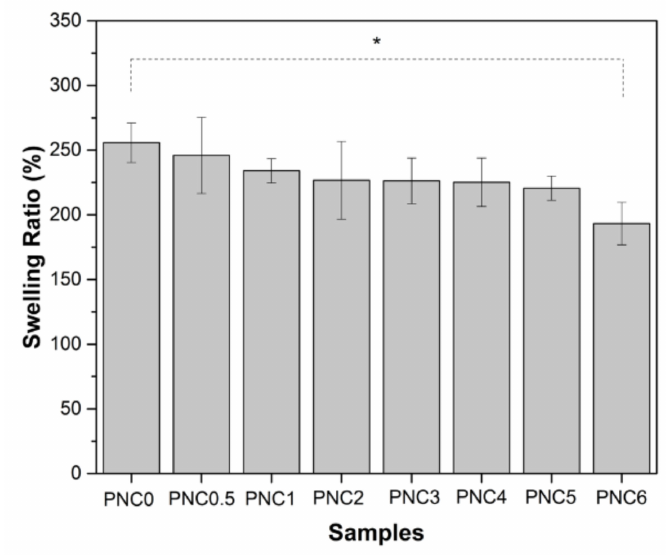
Figure 9. The swelling ratios of PVA–NCC nanocomposite films (*: p < 0.05). The swelling ratios of the nanocomposite films decreased with increasing NCC quan- tities. It is clear that as NCC increases, the equilibrium solvent uptake decreases. This is due to the increased hindrance exerted by the crystals at higher